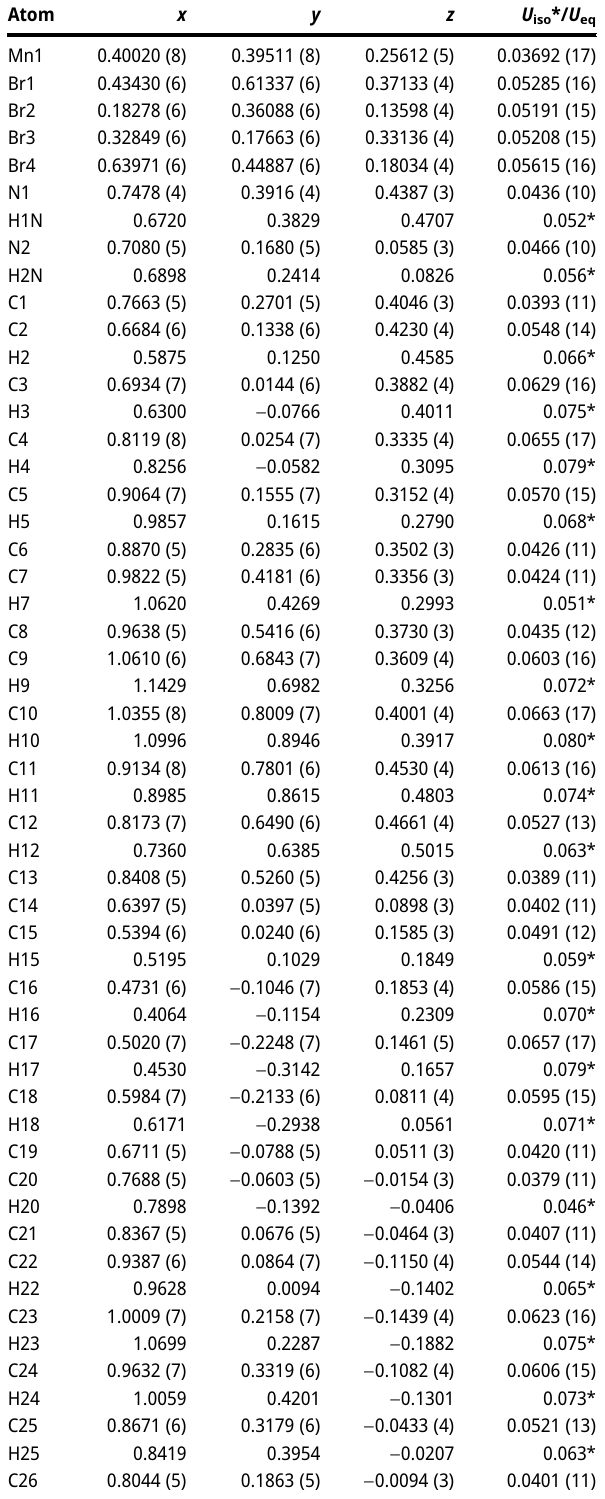
Table  : Fractional atomic coordinates and isotropic or equivalent isotropic displacement parameters (Å 